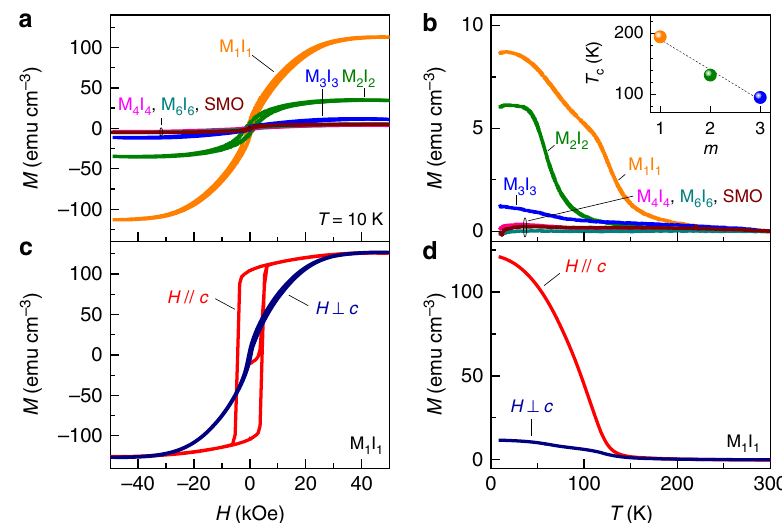
Figure 1 | Global magnetization of SMO–SIO superlattices. ( a ) M ( H ) of symmetric samples at T ¼ 10K after zero-field cooling. ( b ) M ( T ) of symmetric samples at H ¼ 1kOe after field cooling in H ¼ 1kOe. The inset shows the SMO layer thickness ( m ) dependence of the Curie temperature. ( c ) M ( H ) of M 1 I 1 at T ¼ 10K after zero-field cooling. ( d ) M ( T ) of M 1 I 1 at H ¼ 1kOe after field cooling in H ¼ 1kOe.